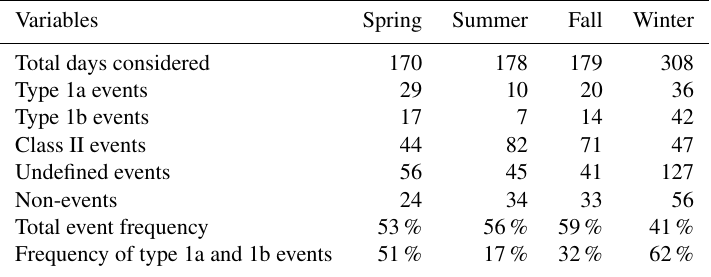
winter (event: 98.60 cm − 3 , non-event: 72.67 cm − 3 ), and fall (event: 258.84 cm − 3 , non-event: 245.61 cm − 3 ) but lower